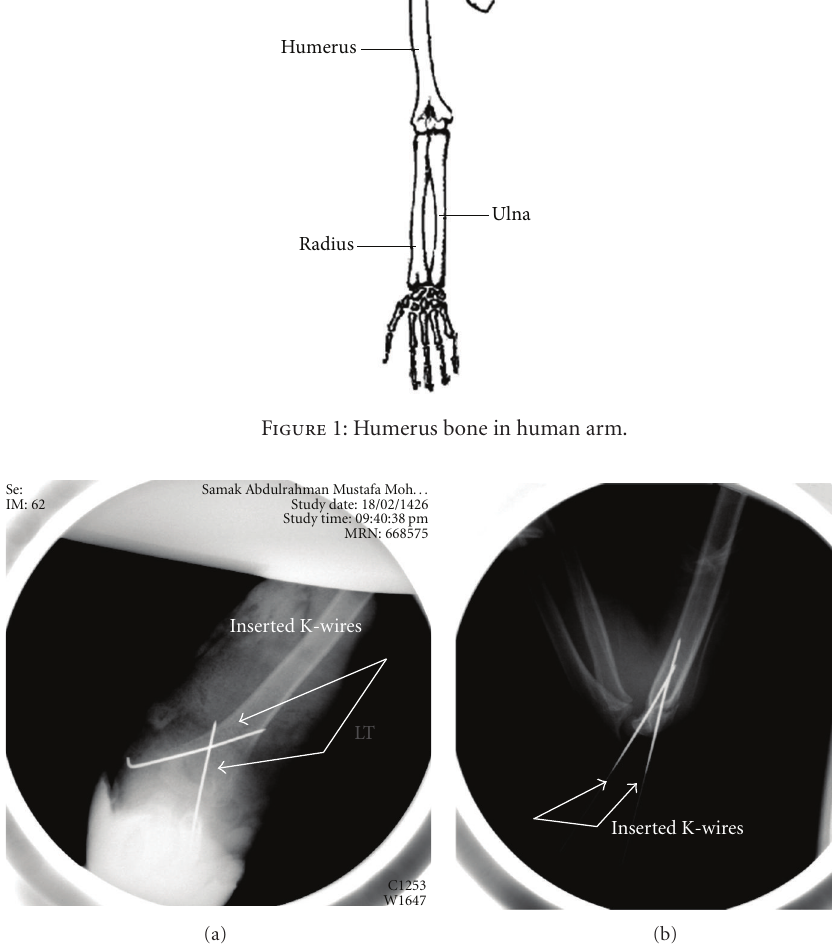
Figure 2: Crossing K-wires fixation treatment techniques adopted by orthopedic surgeons for distal humerus fracture treatment, (a) anterior-posterior view; (b) lateral view.